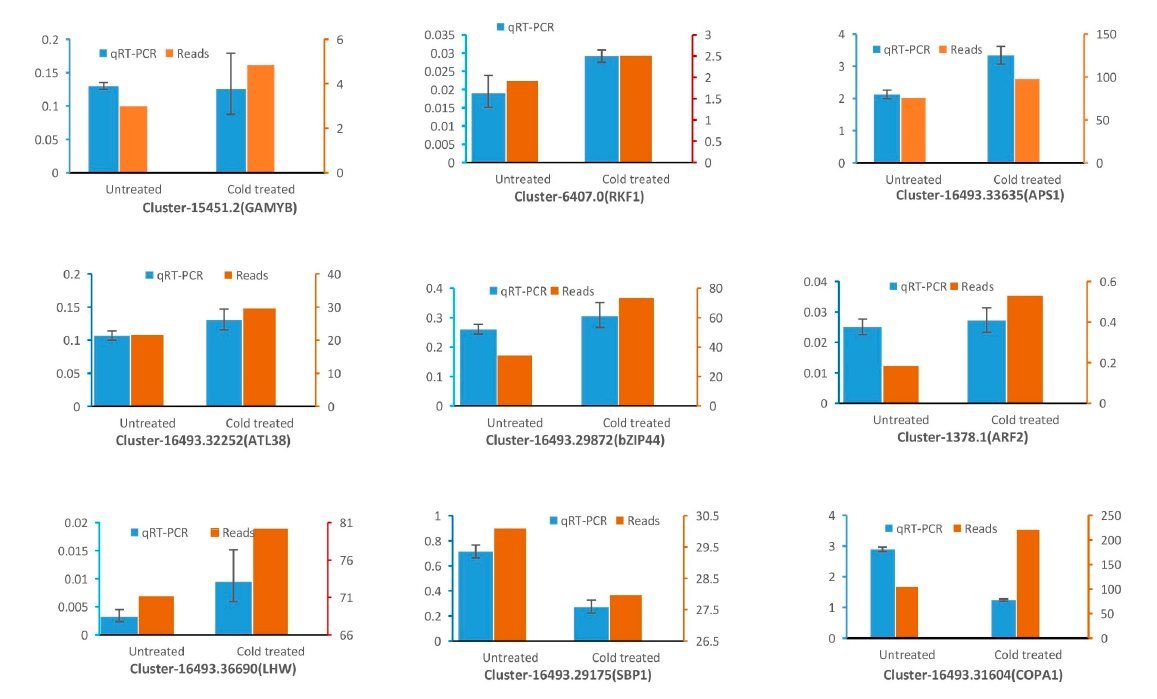
Figure 7. qRT-PCR expression levels of candidate targets detected in shoot of Populus simonii × P. nigra with and without cold